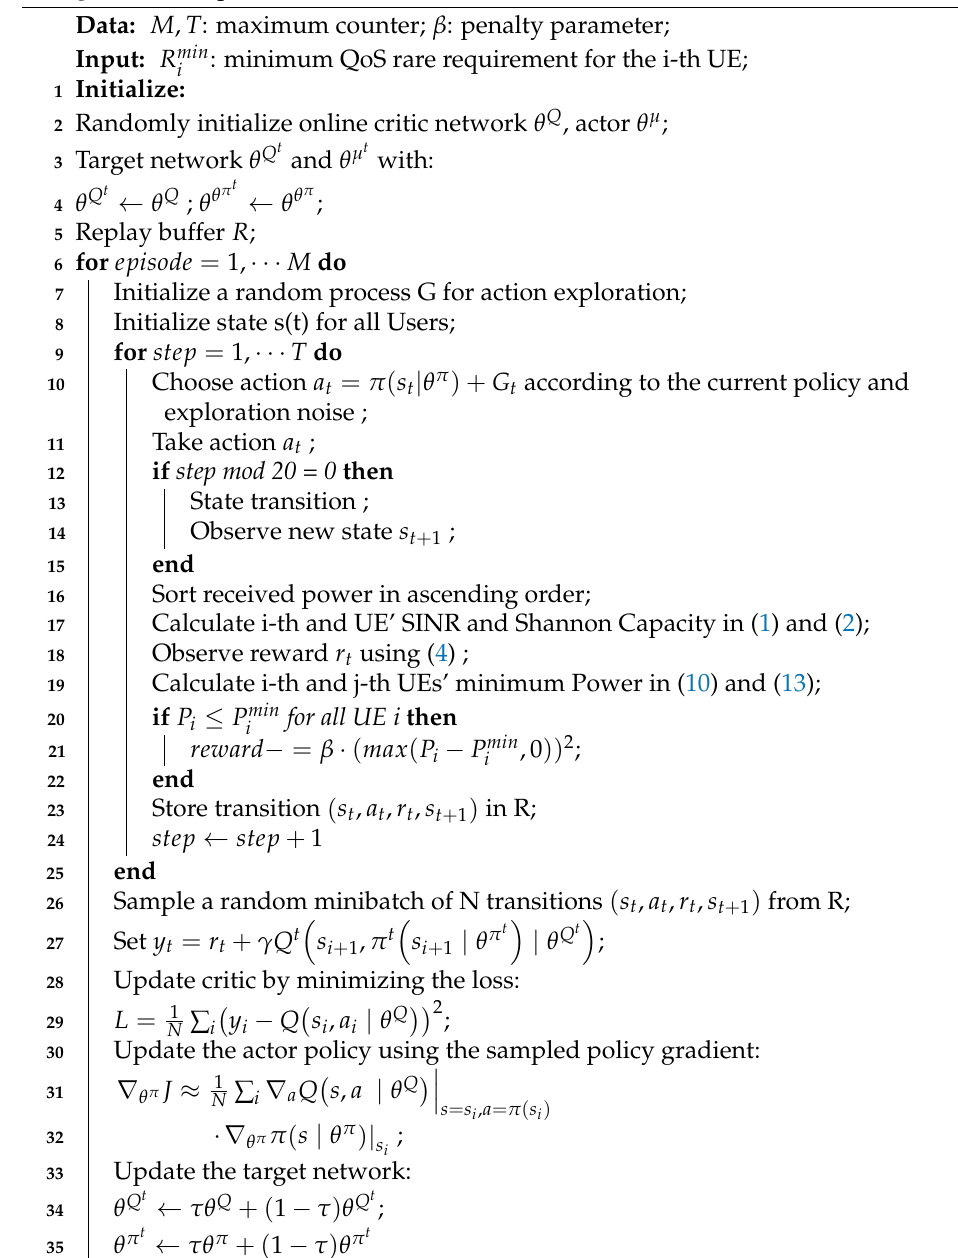
Algorithm 1: Uplink Power Allocation Based on DDPG in